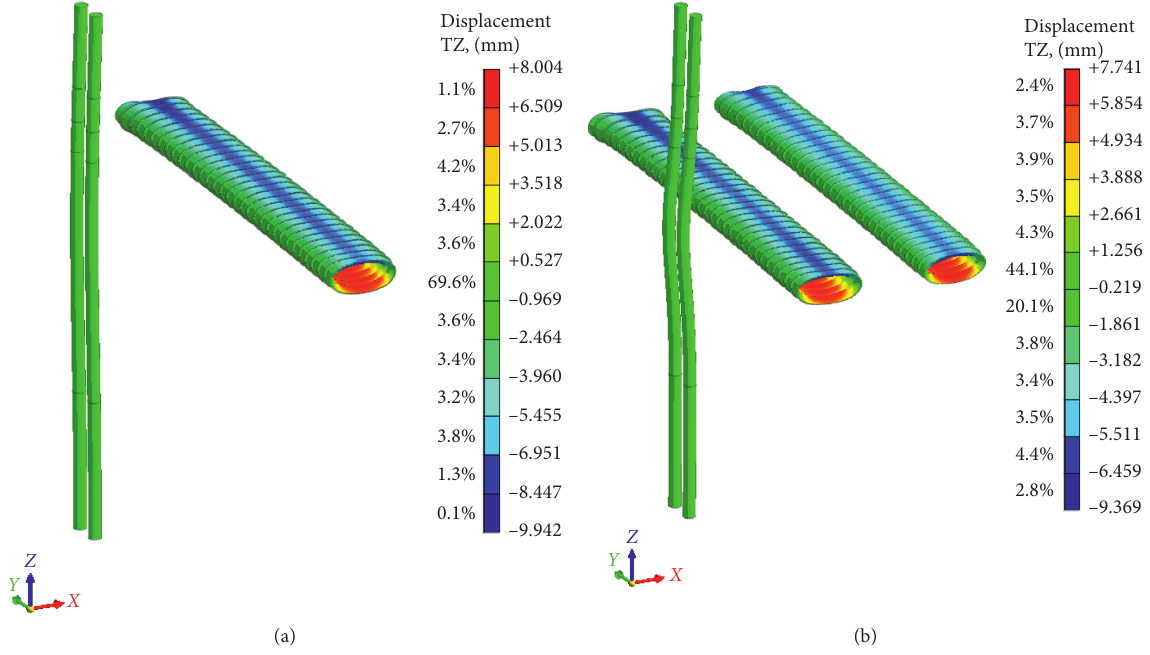
Figure 12: Vertical displacement of pile and tunnel in condition (a). (a) Right line finished. (b) Left line finished.